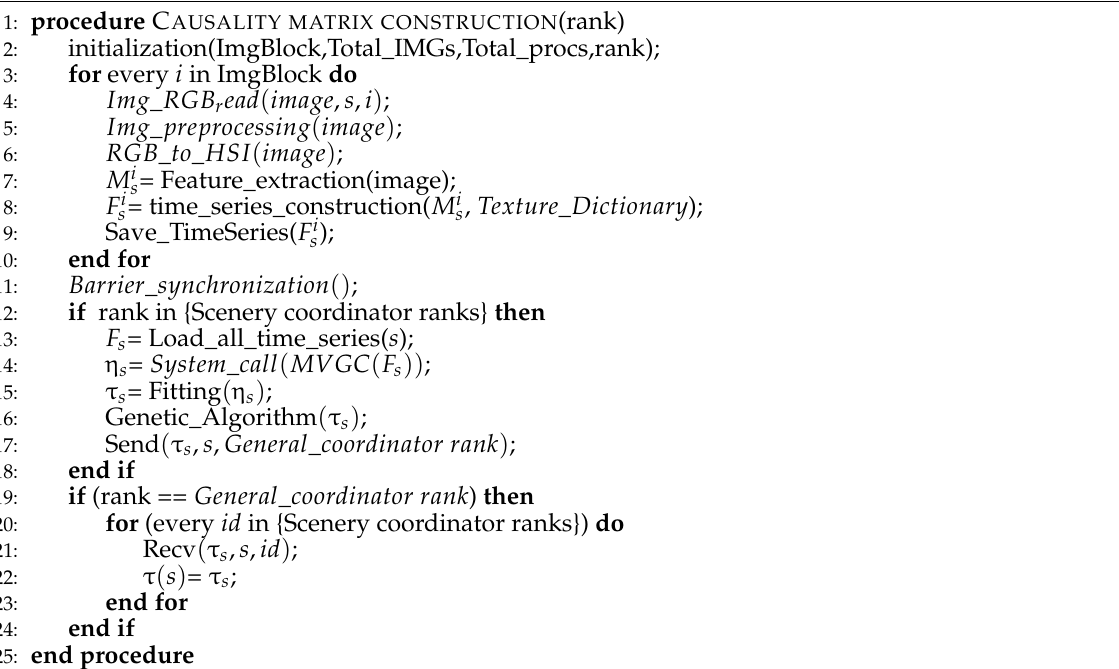
Algorithm 1 Parallel algorithm for the causality matrix